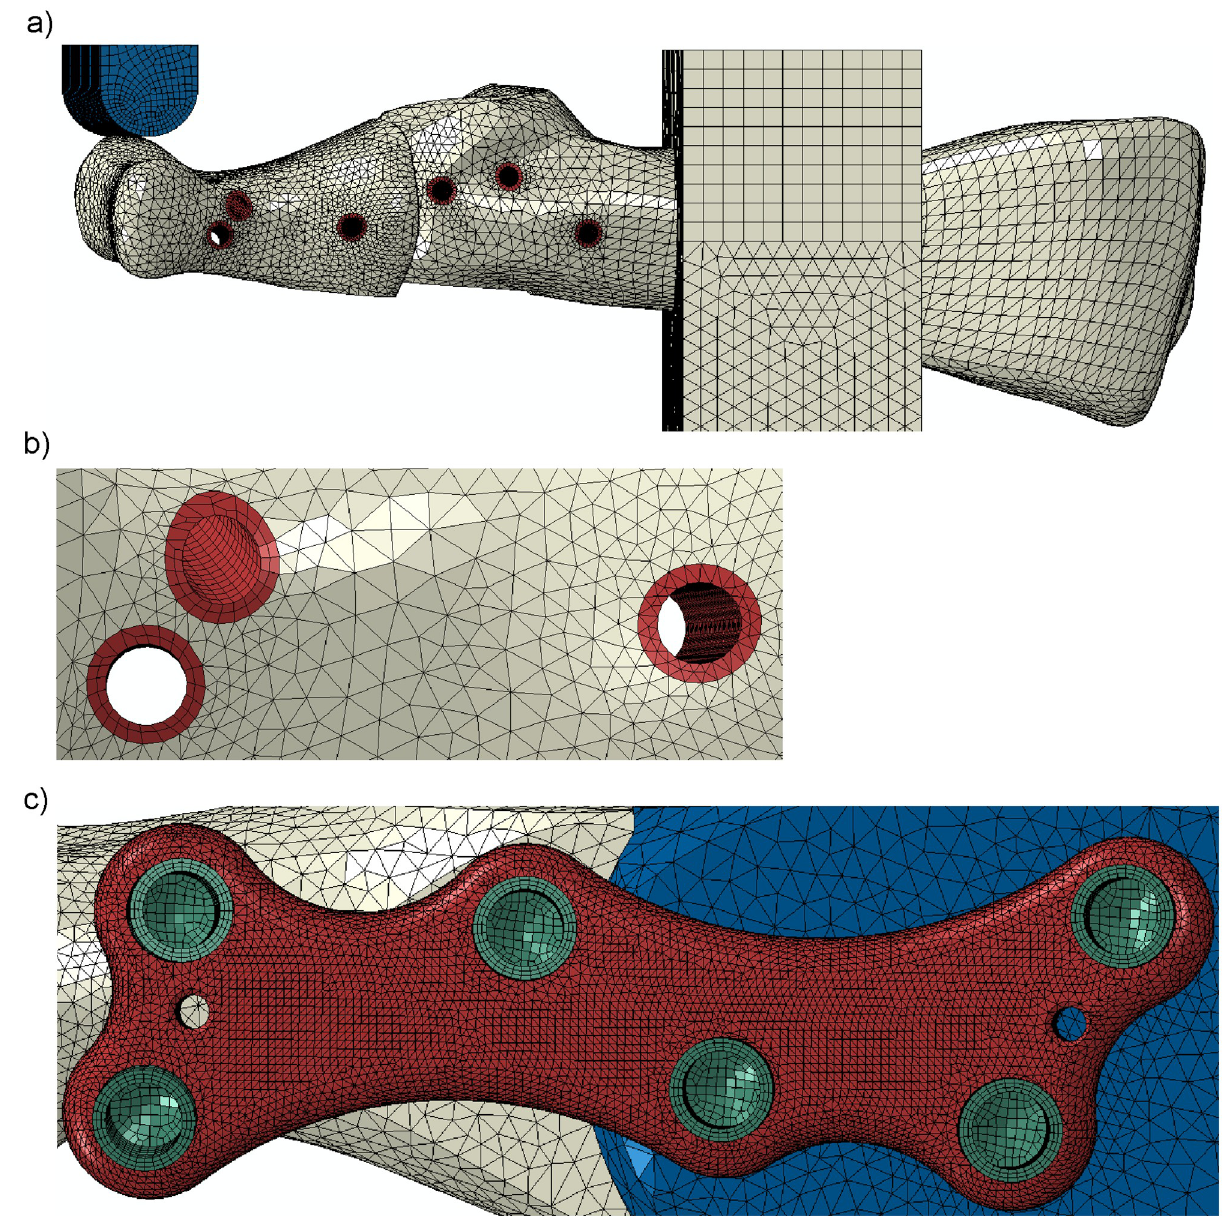
Fig 5. Finite element mesh of the MTP1 joint model: a) lateral view; b) the vicinity of the screws in the proximal phalanx; c) titanium plate and screws.